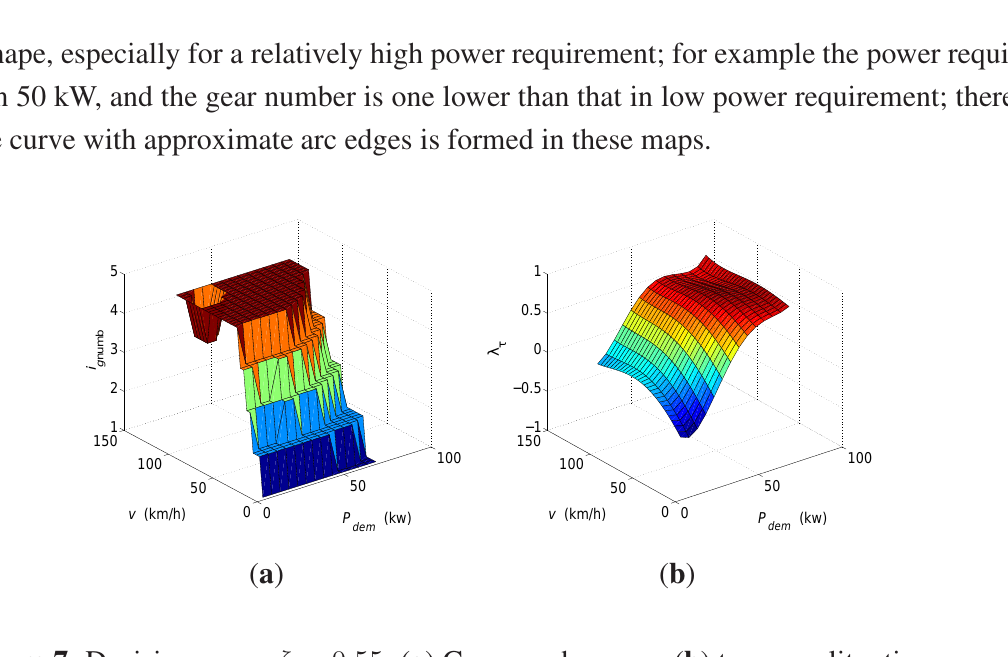
Figure 7. Decision maps, ζ = 0 . 55 . ( a ) Gear number map; ( b ) torque split ratio map.